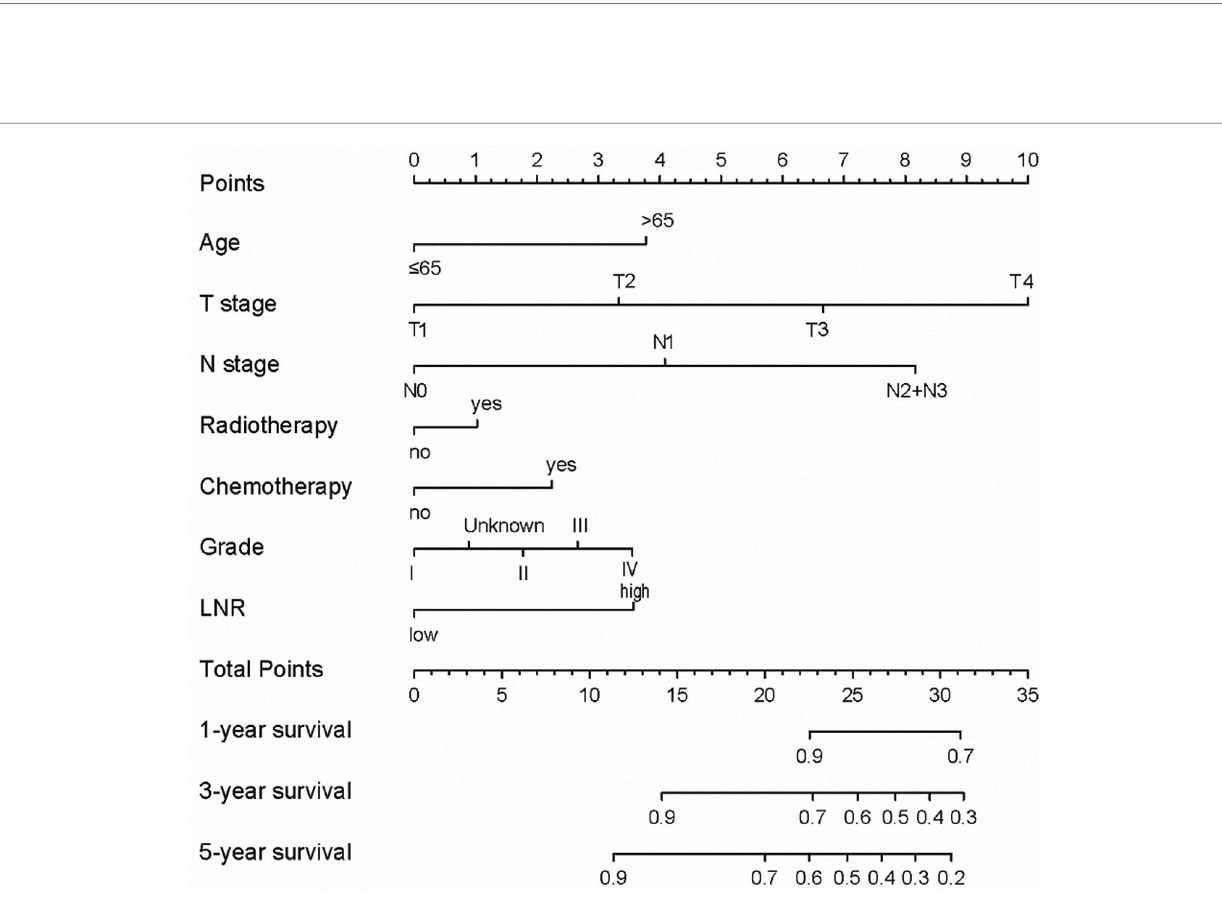
FIGURE 3 | Nomogram to show the weights of variables affecting